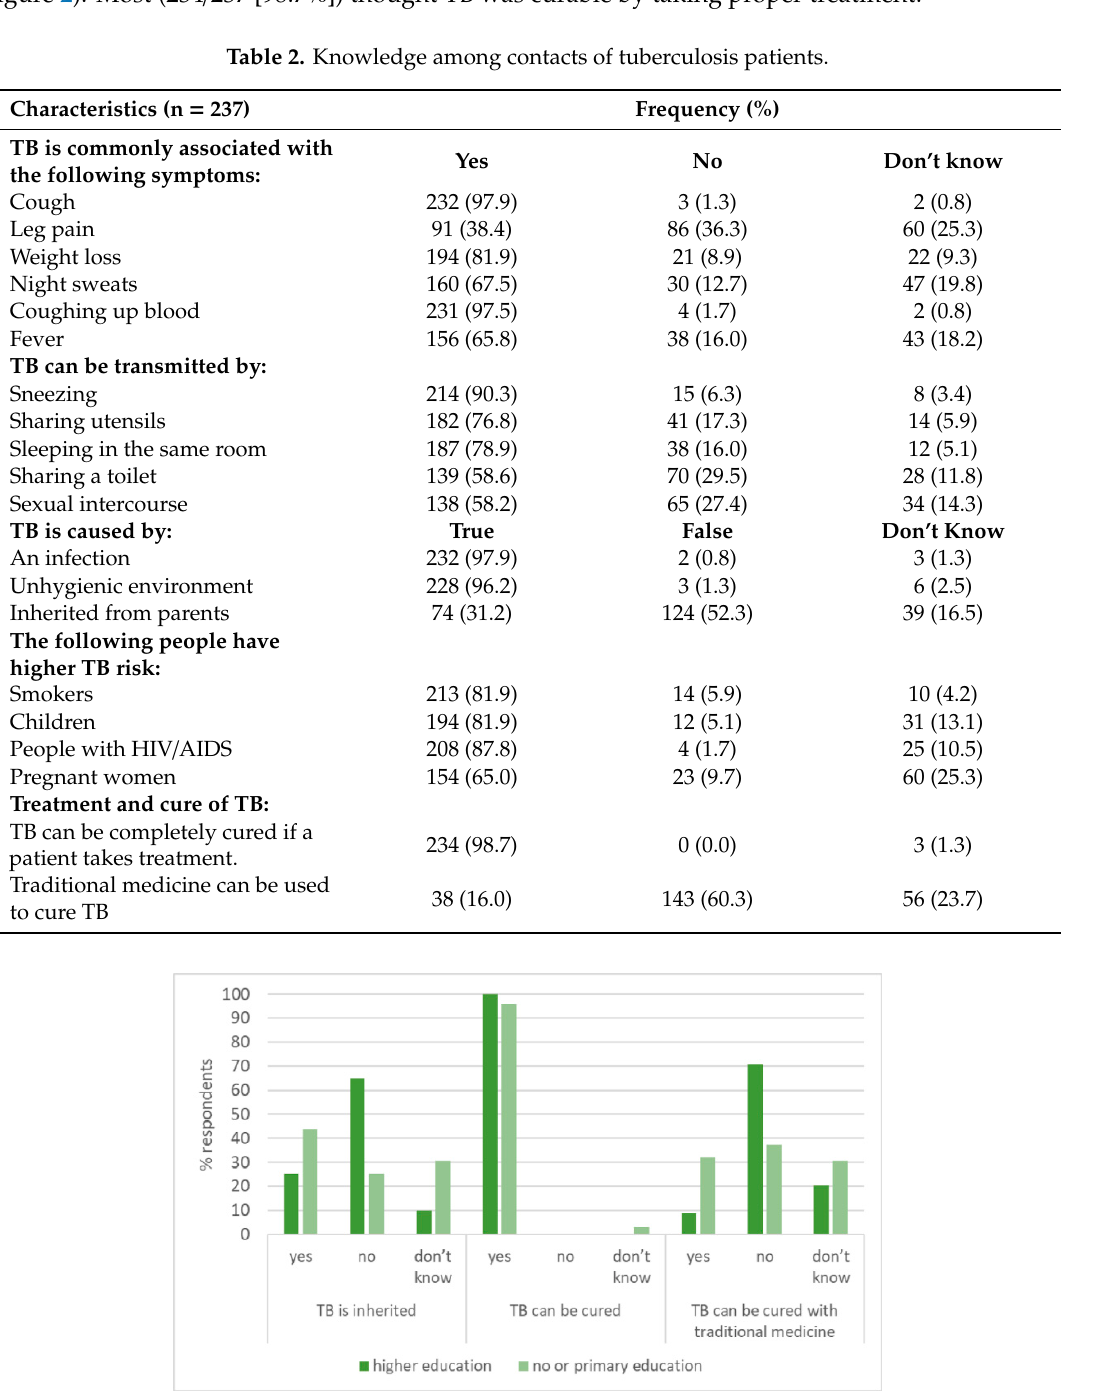
Figure 2. Associations between selected TB knowledge questions and educational status.